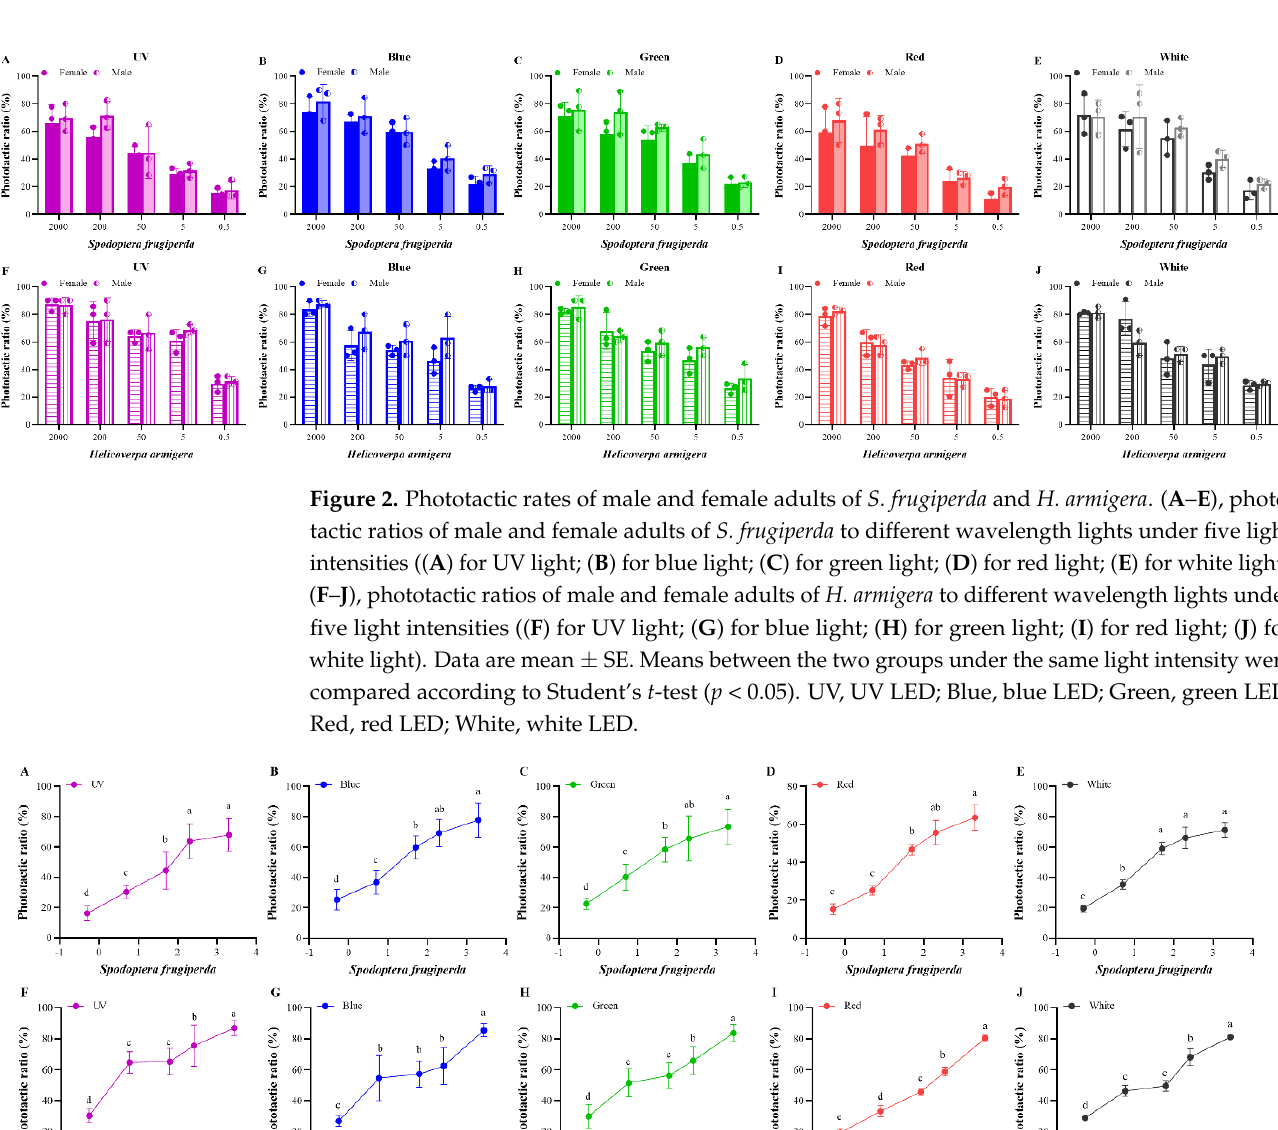
Figure 3. Phototactic rates of S. frugiperda and H. armigera to different intensities. ( A – E ), phototactic ratios of S. frugiperda to different wavelength lights under five light intensities (( A ) for UV light; ( B ) for blue light; ( C ) for green light; ( D ) for red light; ( E ) for white light). ( F – J ), phototactic ratios of H. armigera to different wavelength lights under five light intensities (( F ) for UV light; ( G ) for blue light; ( H ) for green light; ( I ) for red light; ( J ) for white light). The light intensity is 0.5, 5, 50, 200, and 2000 lx, and is transformed into log10 values. Data are mean ± SE. Means with different letters are significantly different according to Dunnett’s test ( p < 0.05, ANOVA). UV, UV LED; Blue, blue LED; Green, green LED; Red, red LED; Black, white